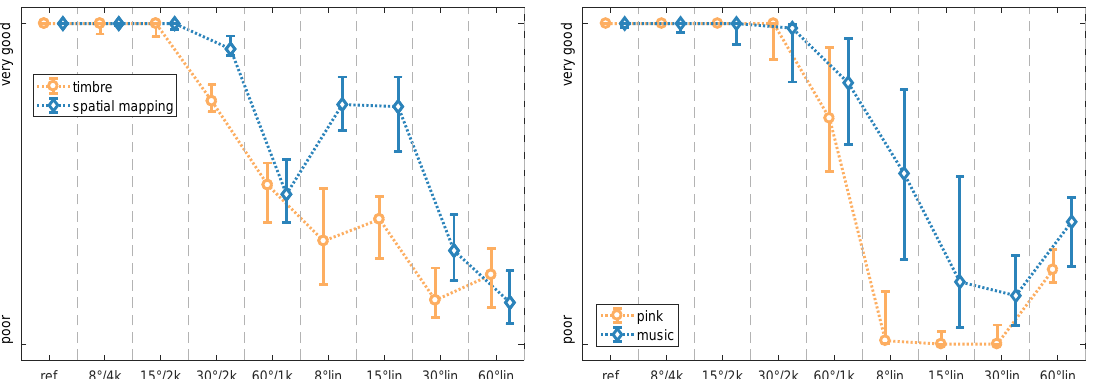
( a ) Timbre and spatial mapping of the pooled data for all ( b ) Continuity of the pooled data (virtual speaker at front tested directions for a frontal source and head orientations of and side, respectively). ϕ = { 12,21,37,78 } ◦ . Figure 3. Median (markers) and 95% confidence interval (solid lines) of ratings from all 10 subjects for testing the perceived difference to the reference (linearly interpolated BRIRs on a 1 ◦ resolution). Settings of the algorithm are indicated by ∆ ϕ / f c , where lin denotes a broadband linear interpolation.